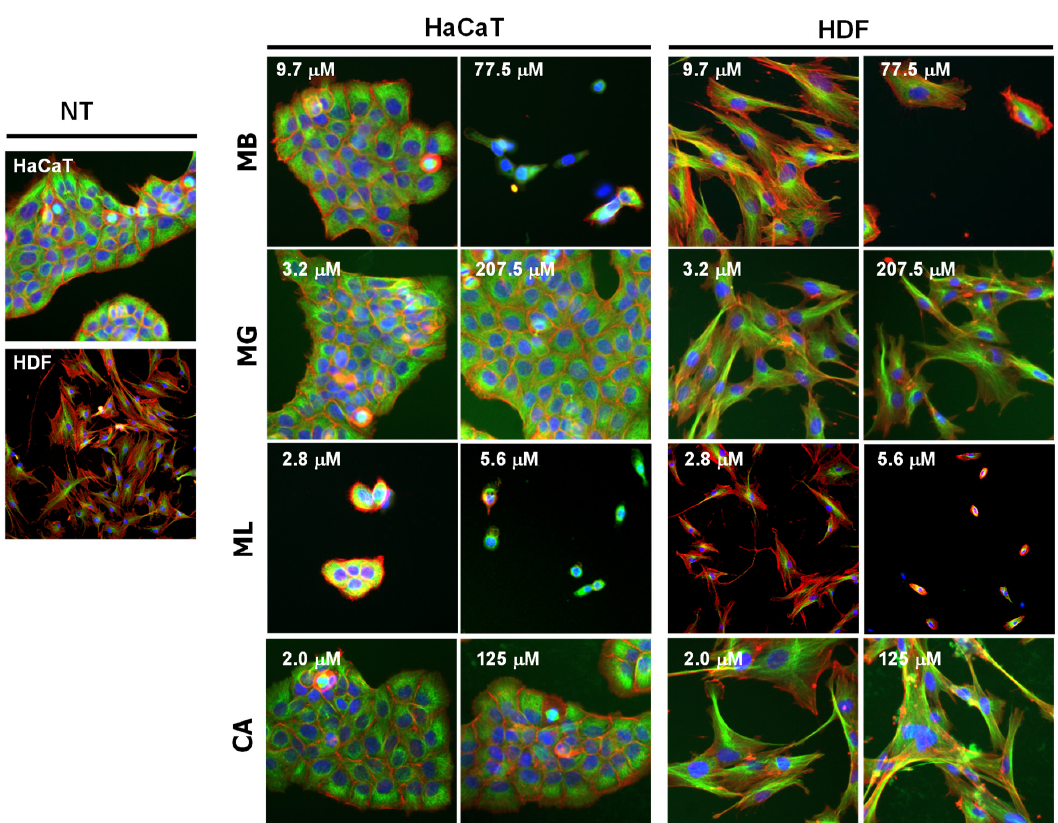
Figure 2. High content imaging showing morphological changes in HaCaT and HDFs exposure to peptides (indicated concentration of MB, MG, ML, and CA) for 24 h. Cells were fluorescently stained for cytoskeleton proteins, α -tubulin (green) and actin (red), and nuclei (blue) to visualize cellular and nuclear morphologies. Cell images were captured using an automated IN Cell Analyzer 2200 microscope. NT indicates no treatment control.